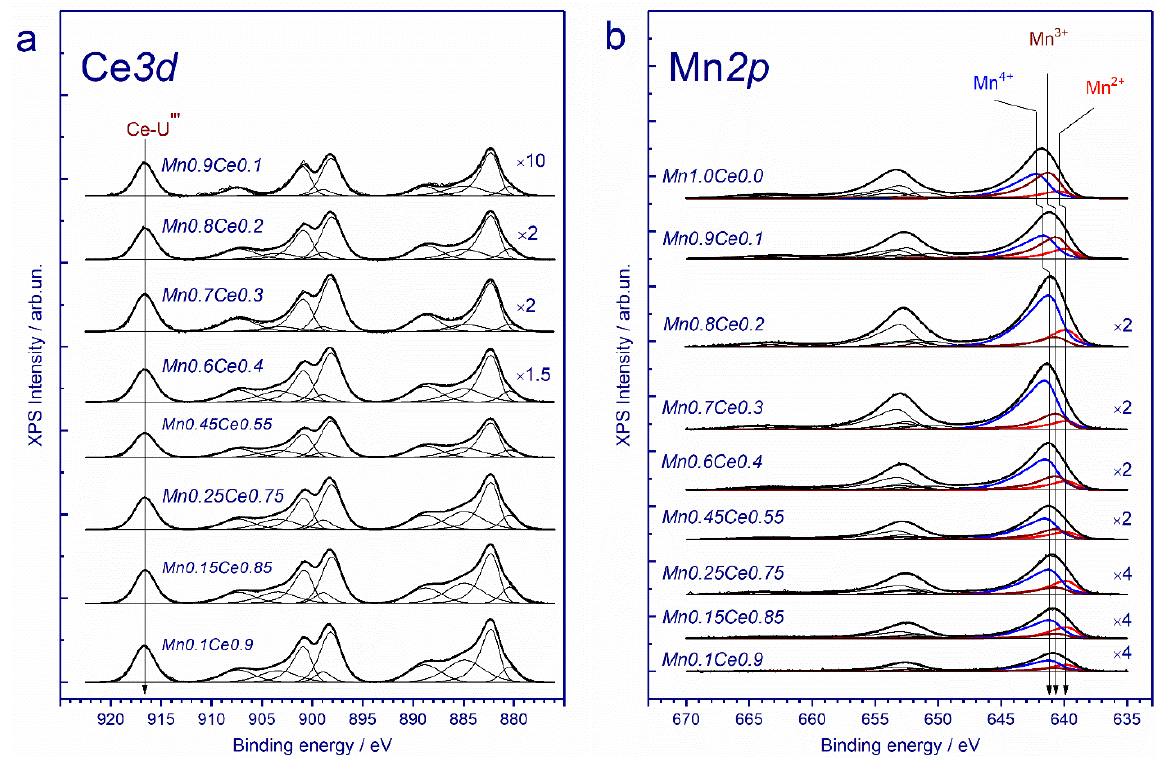
Figure 8. Ce 3d ( a ) and Mn 2p ( b ) core-level spectra of the catalysts under study. The spectra are normalized to the total intensity of the corresponding Ce 3d and Mn 2p core-level spectra.